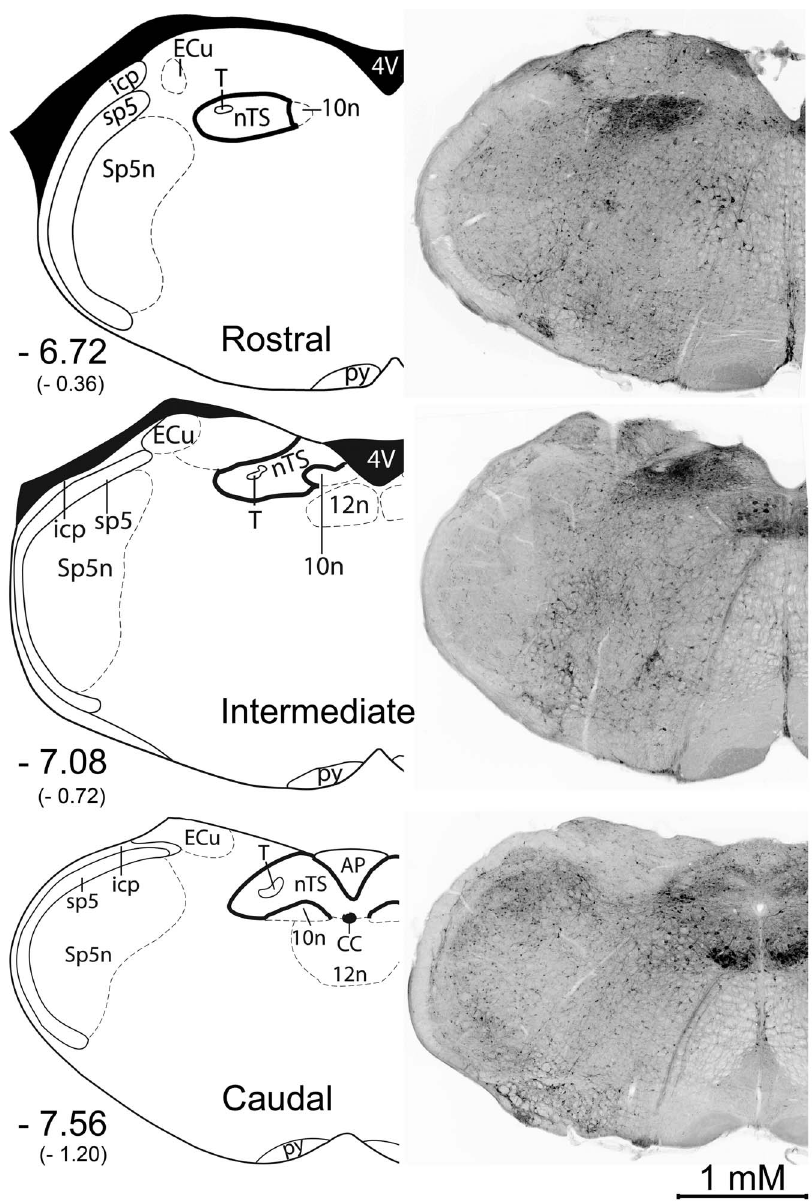
Figure 1. b – galactosidase staining is found throughout the brainstem, but is especially dense within the nTS and hypoglossal nucleus. Left : Three rostrocaudal nTS levels designated as Rostral, Intermediate, and Caudal. Coordinates from Bregma are listed for each nTS level. Numbers in parenthesis represent coordinates relative to the rostral-most (i.e. ‘r1’) portion of the nTS as defined previously [17]. AP: area postrema, CC: central canal, ECu: external cuneate nucleus, icp: inferior peduncle, nTS: nucleus of the solitary tract, py: pyramidal tract, sp5: spinal trigeminal tract, Sp5n: spinal trigeminal nucleus, T: solitary tract, 4V: 4th ventricle, 10n: dorsal motor nucleus of the vagus, 12n: hypoglossal nucleus. Images modified from Paxinos The Mouse Brain in Stereotaxic Coordinates, 2nd Edition. Right : Photomicrographs of fluorescent b – galactosidase staining in the brainstem of a FTL mouse that received no stimulation (Unstim) Images converted to greyscale colors for clarity.